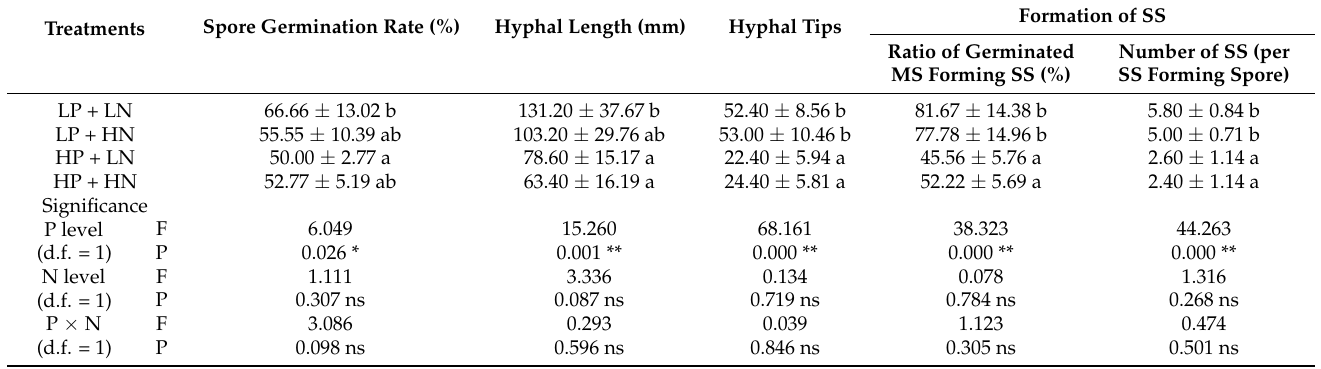
Table 2. Effects of root extracts on Funneliformis mosseae spore germination and hyphal growth. Treatments Spore Germination Rate (%) Hyphal Length (mm) Hyphal Tips